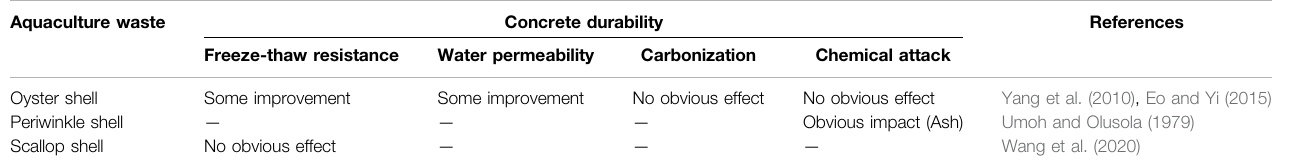
TABLE 7 | The in fl uence of aquaculture waste on the durability of